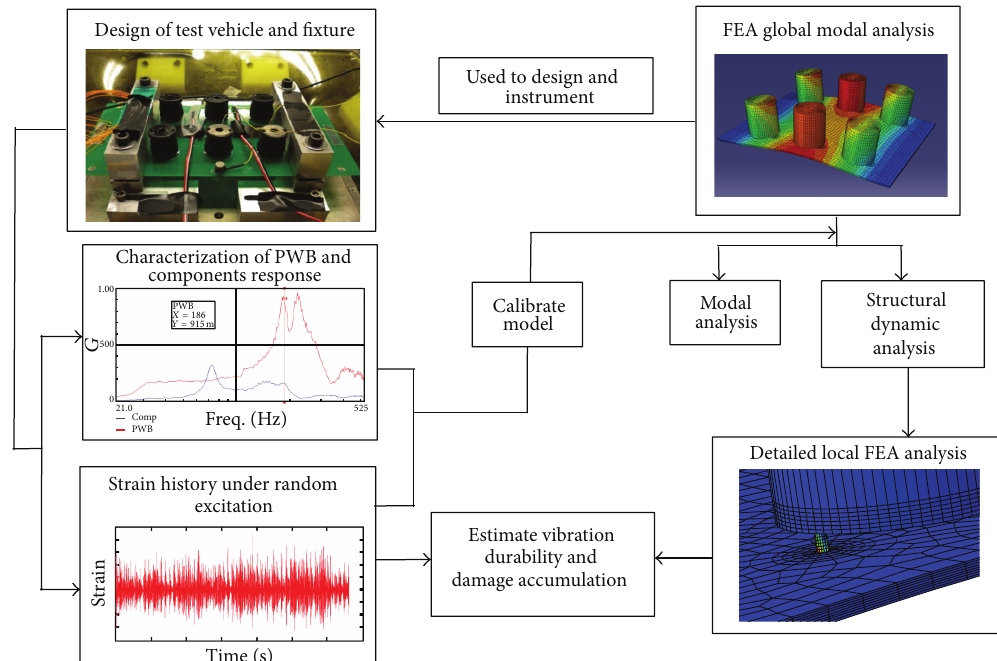
Figure 9: Approach for mapping dynamic loads to fatigue